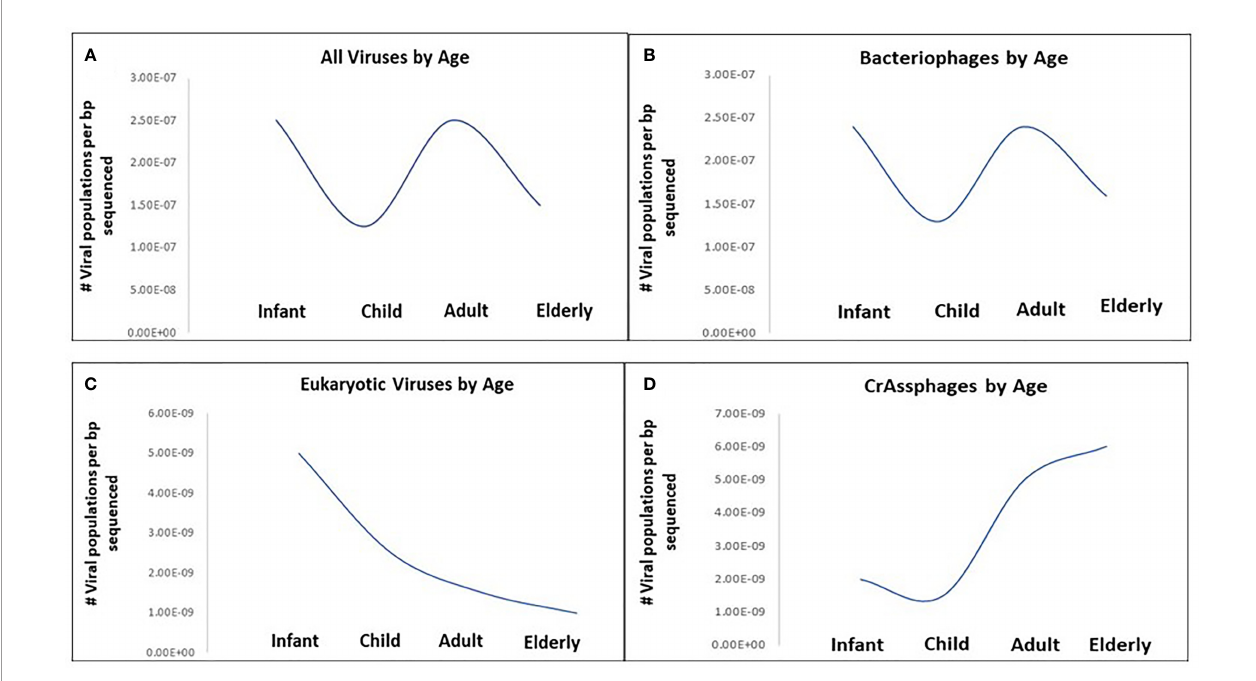
FIGURE 1 | Viral richness changes with age in healthy humans across four age categories: Infant (0-3 years), Child (3-18 years), Adult (18-65 years) and Elderly (65+ years). (A) All viruses by age, (B) bacteriophages by age, (C) eukaryotic viruses by age, (D) CrAssphages by age. Viral richness quanti fi ed as the median number of viral populations per base-pair sequenced for each age category based on results from Gregory et al.,